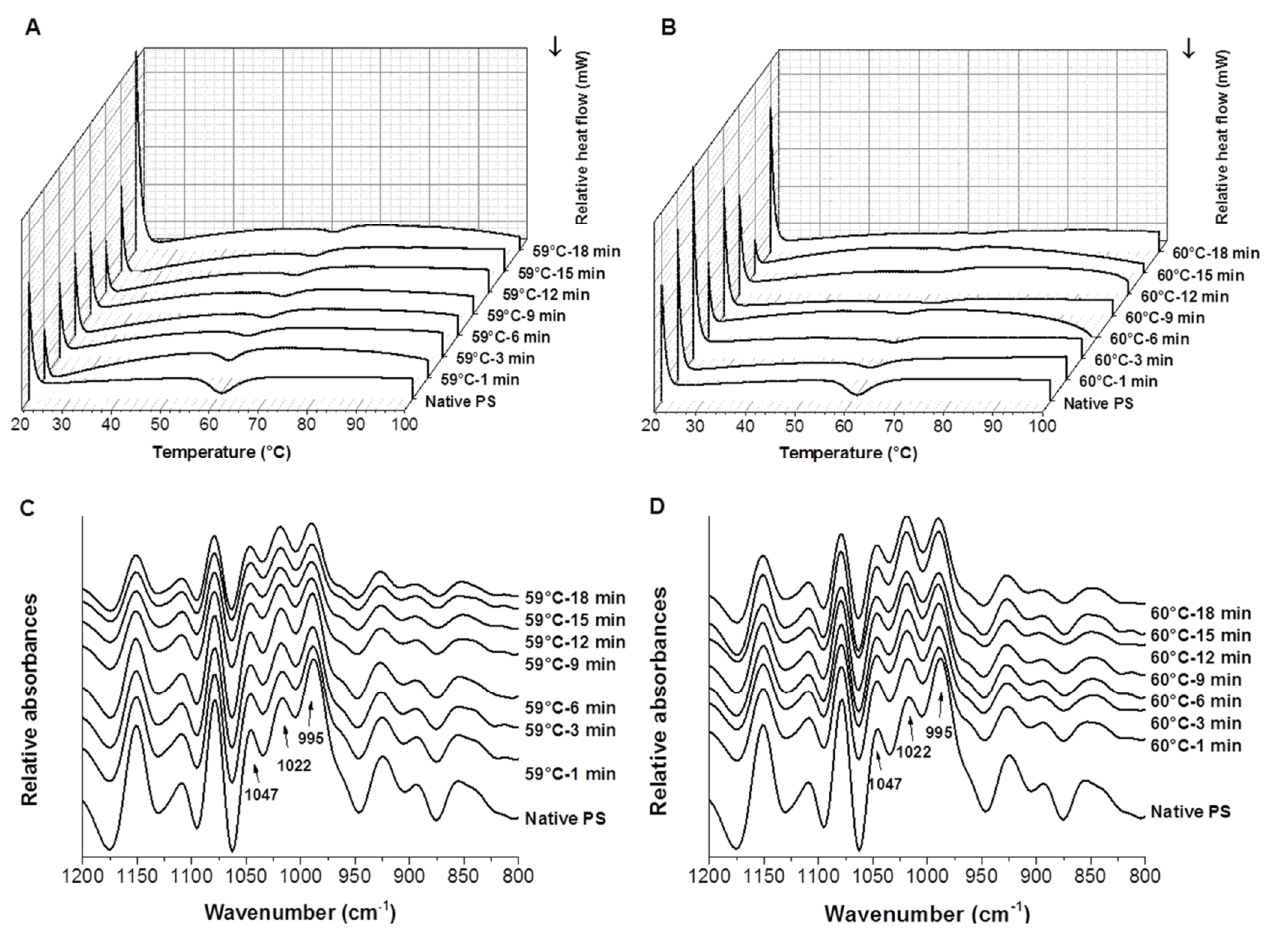
Figure 1. DSC thermograms ( A , B ) and FTIR spectra ( C , D ) of native and partially gelatinized potato starch samples (A,C: pre-heated at 59 °C; B,D: pre-heated at 60 °C). Table 1. DSC parameters of native and partially gelatinized starch samples.